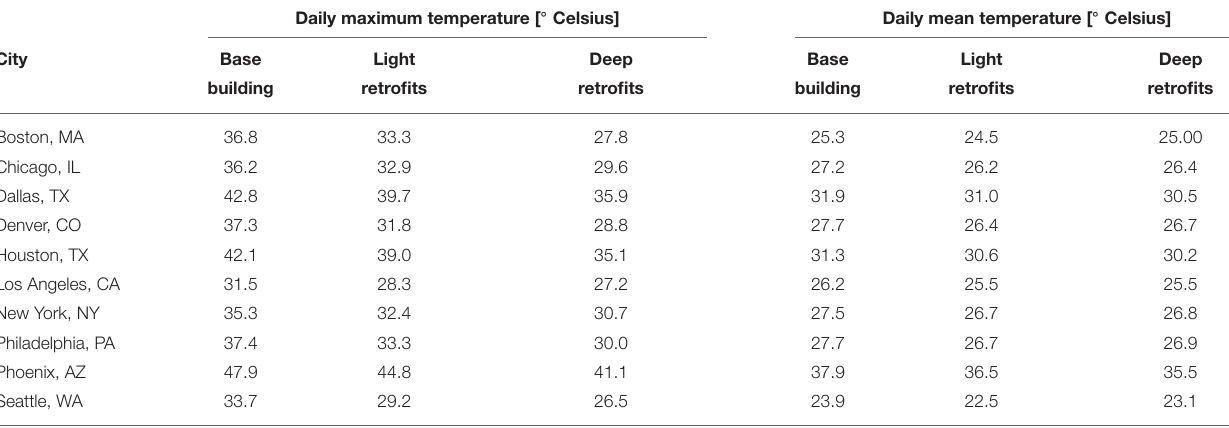
TABLE 3 | Simulated indoor temperatures [ ◦ Celsius] (without AC) under light and deep retrofits by city. Daily maximum temperature [ ◦ Celsius] Daily mean temperature [ ◦ Celsius] City